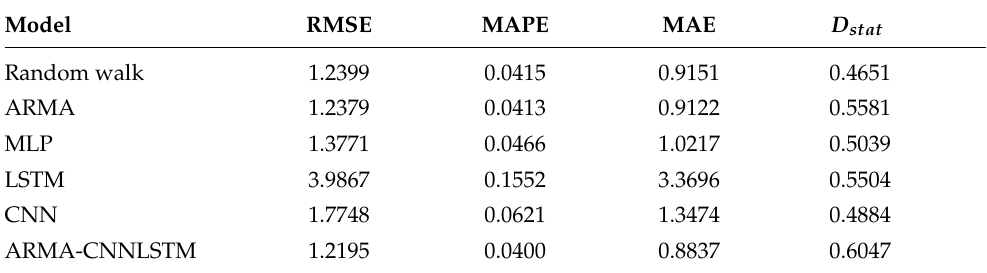
Table 2. Comparison of the predictive abilities of different models for EU ETS financial time series.